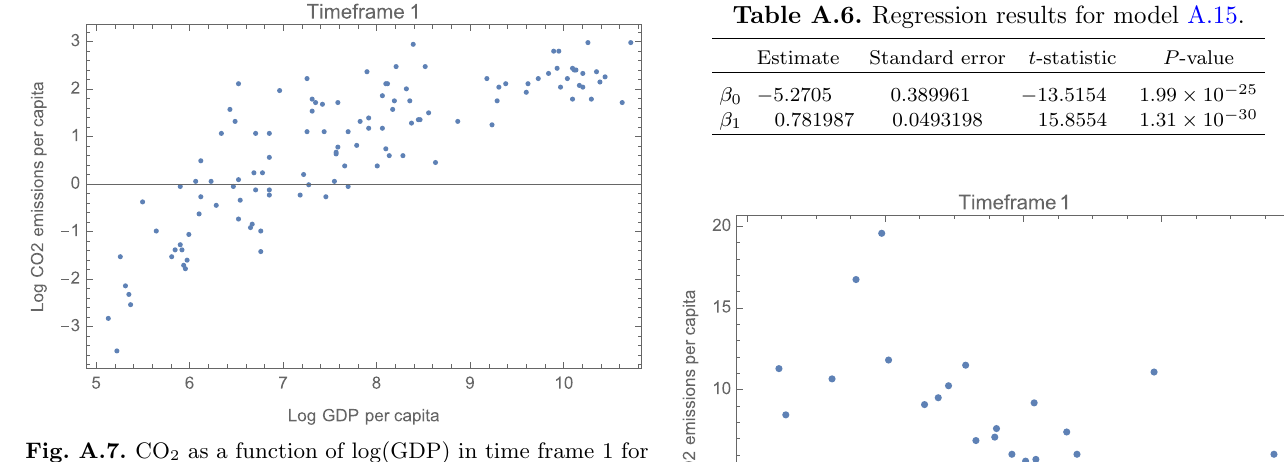
Fig. A.7. CO 2 as a function of log(GDP) in time frame 1 for all countries.